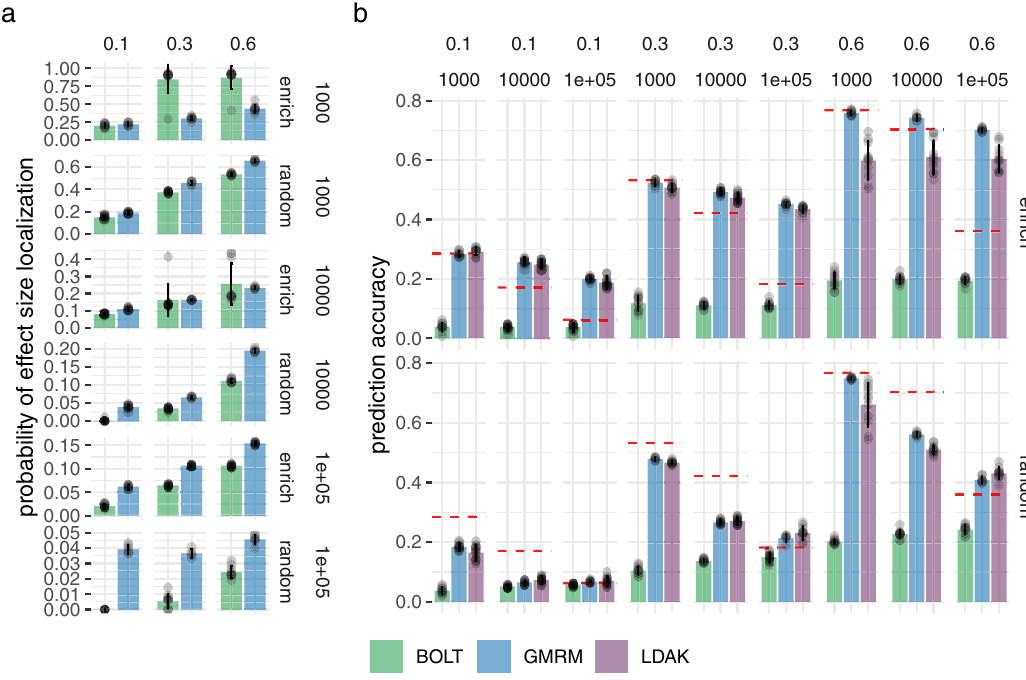
Fig. 2 Simulation study for the performance of our BayesRR-RC model implemented in the GMRM software against existing approaches for localisation of associations and genomic prediction. a Probability of detecting genomic regions containing simulated causal variants by a Bayesian regional fi ne-mapping approach (GMRM: blue) versus standard mixed linear model association (MLMA) testing (BOLT: green). The column facets give the simulated heritability and rows give the number of causal variants and whether the effect sizes differed across genomic annotation groups (enrich) or were randomly assigned (random). b Correlation of a genomic predictor and a phenotype in an independent sample when the genomic predictor is created from GMRM effects sizes (blue), MLMA effect sizes using BOLT (green), and the optimal effect sizes obtained from individual-level and summary statistic models implemented in the Mega-PRS LDAK approach (purple). The column facets give the simulated heritability and the number of causal variants. The row facets give whether the effect sizes differed across genomic annotation groups (enrich) or were randomly assigned (random). The red lines give the expected prediction accuracy based on ridge regression theory. Error bars show the SD in both UK Biobank data genotyped at 8,433,421 imputed SNP markers.